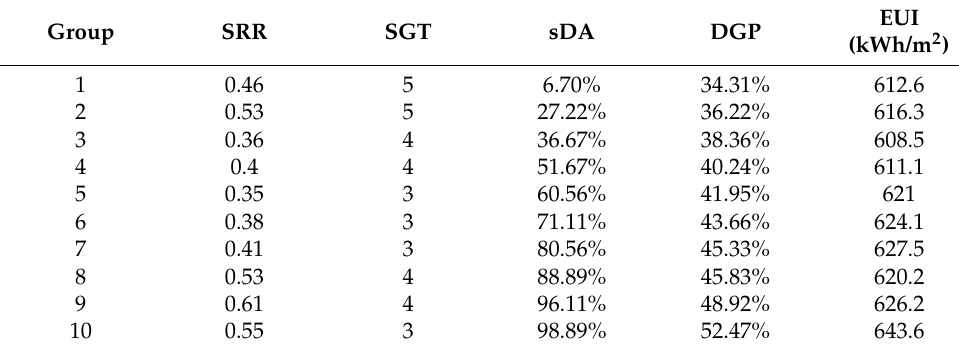
Figure 21. Pareto frontier images of no shading commercial atrium. Table 14. No shading commercial atrium pareto-front solution